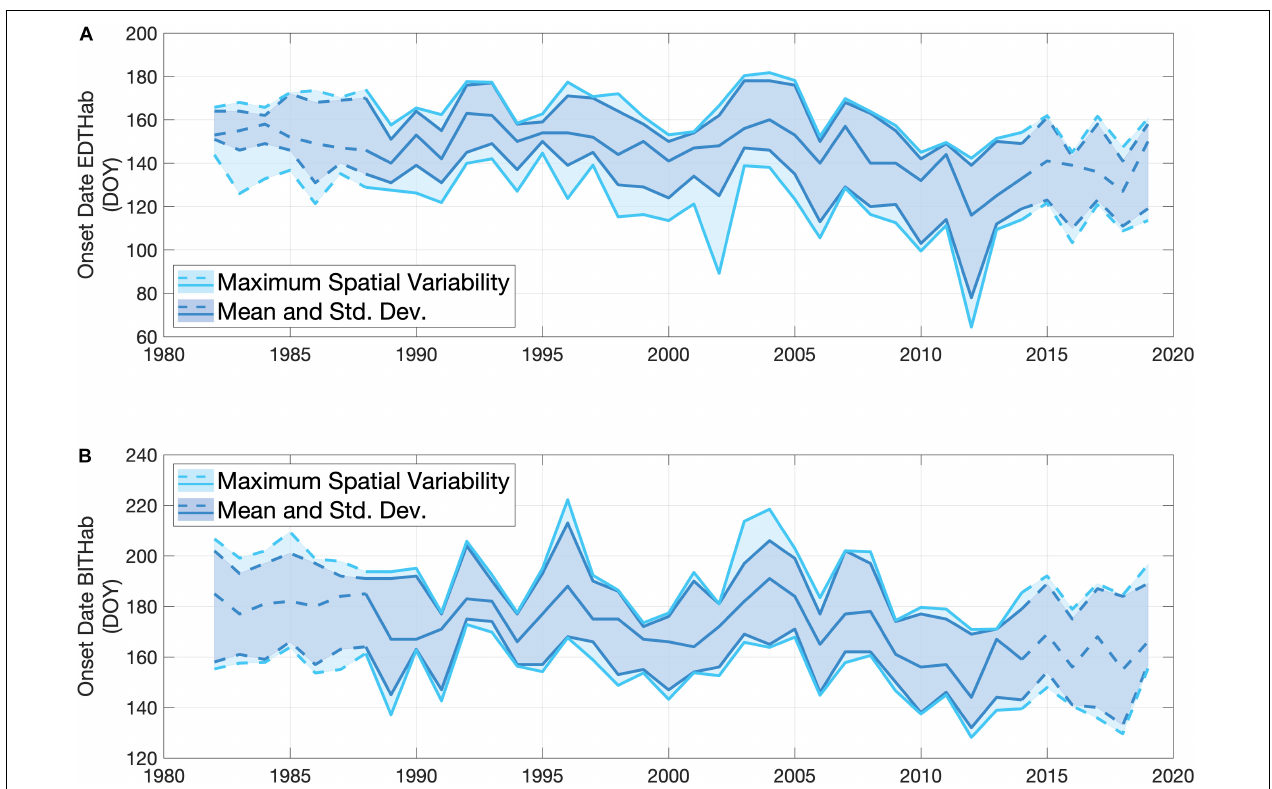
FIGURE 5 | Interannual variability in the onset dates of EDTHab (A) and BITHab (B) for A. catenella in the central basin of the Bay of Fundy (12 grid points) over the time period of SST data availability (1982 to 2019). The darker lines and shaded areas represent the mean arrival date over the central basin for the mean temperature (central line) and ± 1 standard deviation defining the habitats (obtained from Figure 4 ). The lighter lines and shaded areas represent the spatial variability in the occurrence of the end members of the temperature envelope over the 12 grid points of the central basin in each year. The upper (lower) light blue line corresponds to + 1 standard deviation (– 1 standard deviation) obtained when estimating the onset of the thermal habitat using the mean temperature + 1 standard deviation (– 1 standard deviation). The solid lines in all the cases correspond to the time period (1988–2014) of A. catenella data availability, while dashed lines represent the period of only OISST data